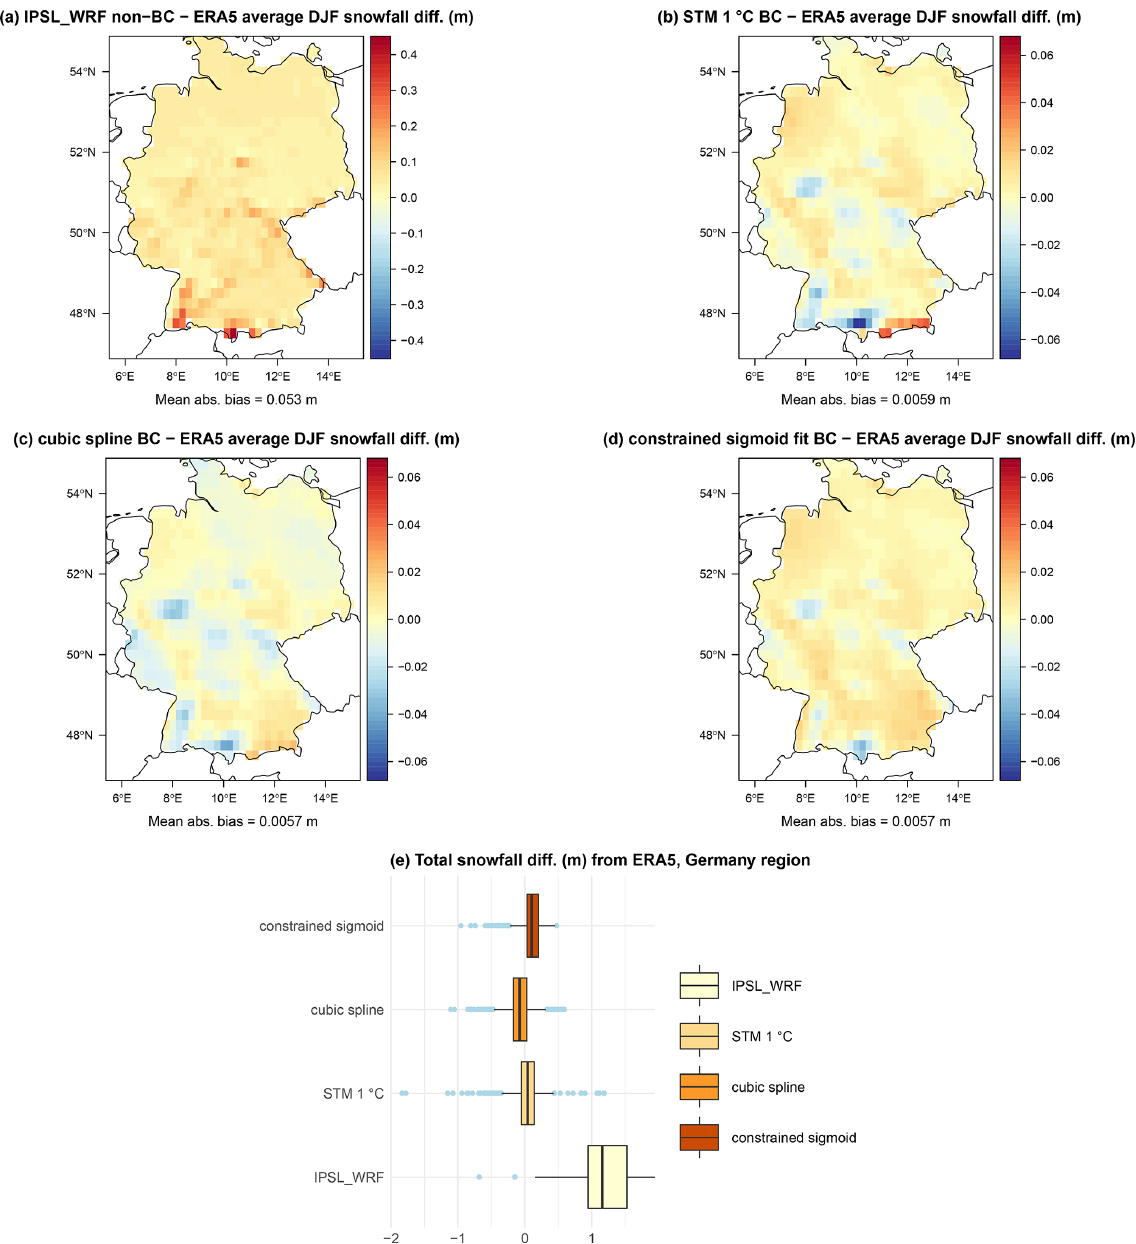
Figure 13. Maps of average 1979–2005 DJF snow differences over Germany between raw IPSL_WRF (a) , STM (b) , cubic spline regres- sion (c) , sigmoid fit (d) bias correction, and ERA5. Corresponding summary box plots are shown in panel (e)